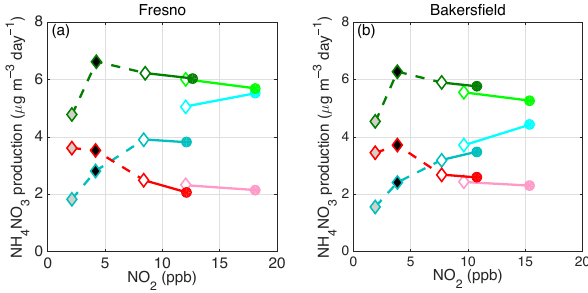
Figure B1. Wintertime NH 4 NO − production (µgm − 3 day − 1 ) by 3 OH-initiated chemistry versus daytime (10:00–15:00LT) NO 2 (ppb) for each individual HO x precursor: O( 1 D) + H 2 O (red), HONO (turquoise), and CH 2 O (green). Data are tethered present- day 3-year medians on weekdays (closed circles) and weekends (open diamonds) in Fresno (a) and Bakersfield (b) . Lighter tint data are tethered 3-year medians at the start of the record (2001–2004). There is no significant difference between medians and means. Pre- dicted NH 4 NO − production calculated at − 50% weekend NO x 3 (NO x black-filled diamond) and − 75% weekend NO x (gray-filled diamond) are also